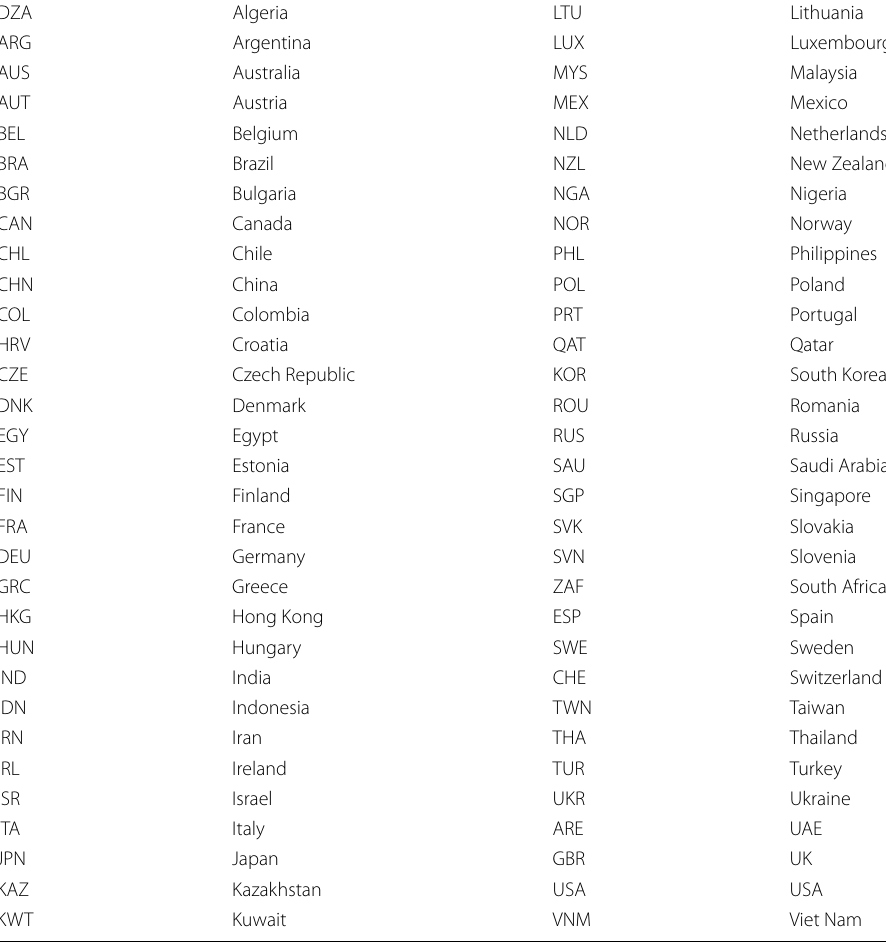
Table 3 Country codes and names.